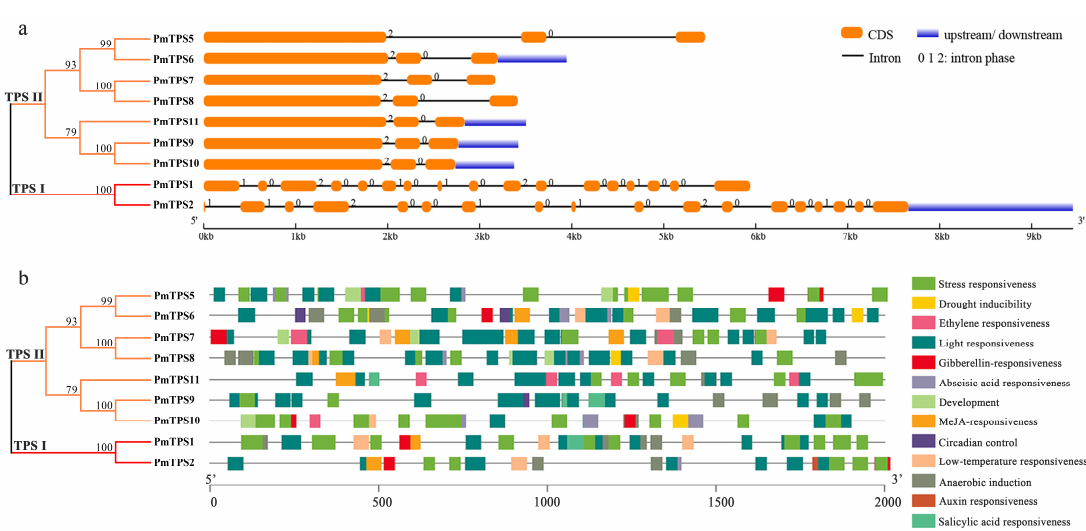
Figure 4. Gene structure and promoter elements of TPS genes within P. mume . ( a ) Exons and introns structure of TPSs in P. mume . The orange round-corner rectangle represents exons, the blue rectangle depicts untranslated region (UTR) regions, the black line shows introns, and numbers (0, 1, 2) represent the intron phase. ( b ) Cis -acting elements of the TPSs promoter in P. mume . Two thousand bp upstream regions of PmTPS genes were used for predicting cis -acting elements. Di ff erent color rectangles represent distinct cis -acting elements in response to abiotic stress, phytohormone, circadian regulation, and plant development.